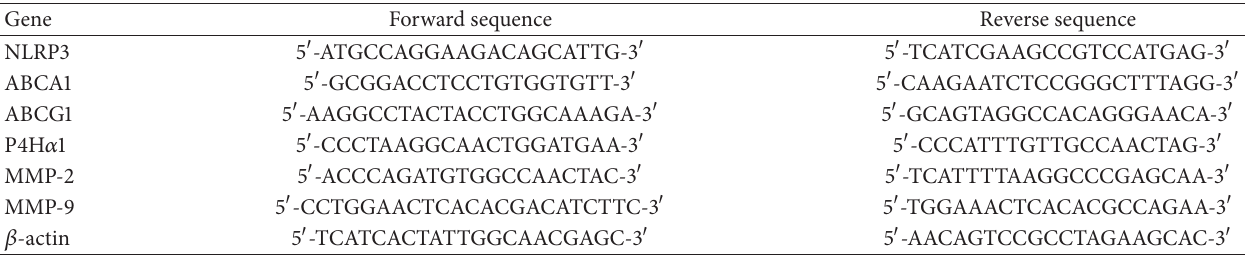
Table 1: Primer sequences for real-time PCR.